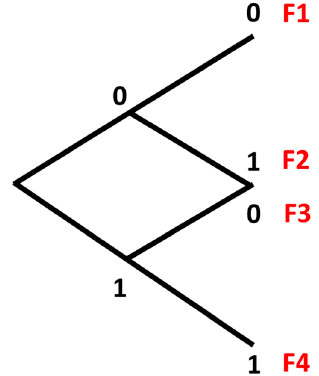
Figure 2. Pattern of factor’s change.